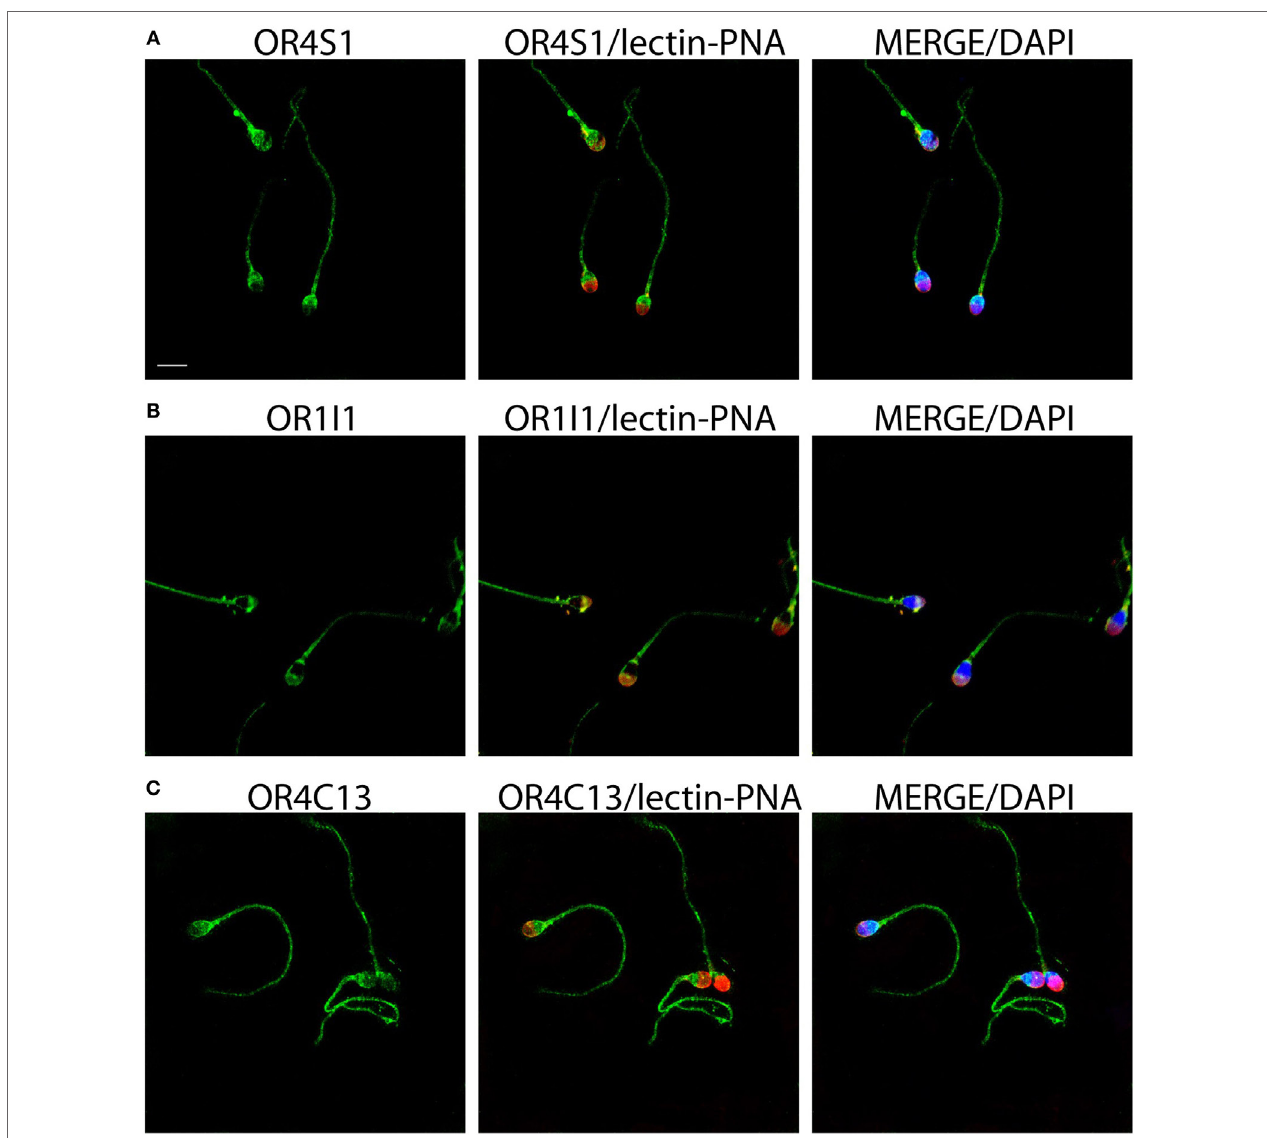
FigUre 2 | Representative images of OR4S1 (a) , OR1I1 (b) , and OR4C13 (c) protein expression (green) by confocal analysis in sperm cells. Nuclei were counterstained with DAPI and acrosomes with lectin-PNA (red). Scale bar 10 µm.